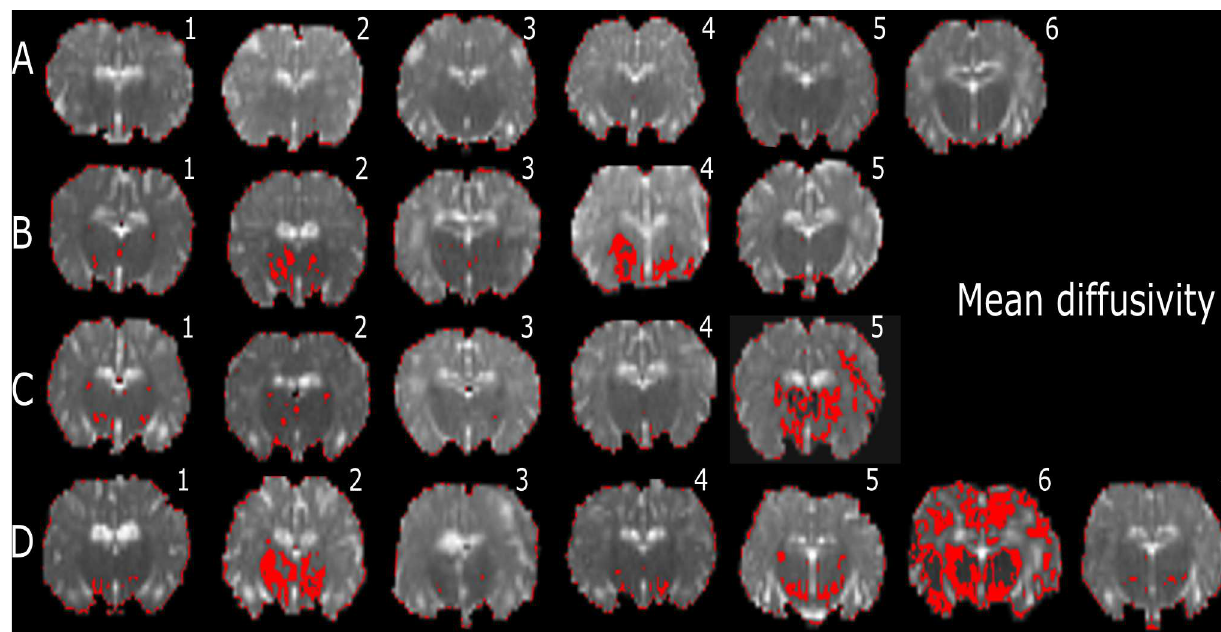
Fig 6. Representative slices of whole-brain DTI colour maps of the thalamus (Th) for mean diffusivity (MD). Voxel diffusivity intensities falling belowthe low threshold are shown in red for MD measurements for all lamb brains. All low-diffusion maps are overlaidon diffusion images for a slice passingthrough the Th. All lambs in the unoperatedcontrol (Cont n = 6; A) group had no low MD values in the Th, but low MD values appearedin the Th of about lambs followingsham surgery (Sham n = 5; B), lambs followinginjuriousventilation (INJ n = 5; C), and lambs followingumbilicalcord occlusion(INJ+UCO n = 7; D).